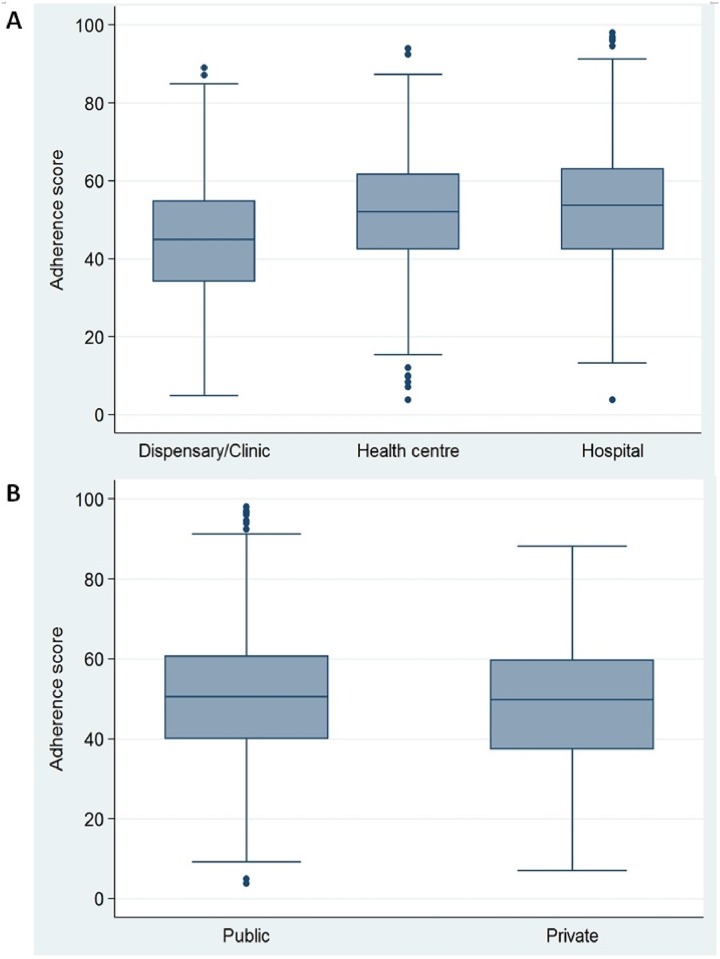
Distribution of adherence scores for observed first-visits ANC in TSPA 2015–2016 (n = 1756).(A) Provider adherence to first-visit ANC standards according to facility type. (B) Provider adherence to first-visit ANC standards according to managing authority. Boxes show the limits of 25th and 75th percentiles. Horizontal lines inside the boxes show the median values. Bars show the lower and upper limits of 95% CI. The dots show outliers.